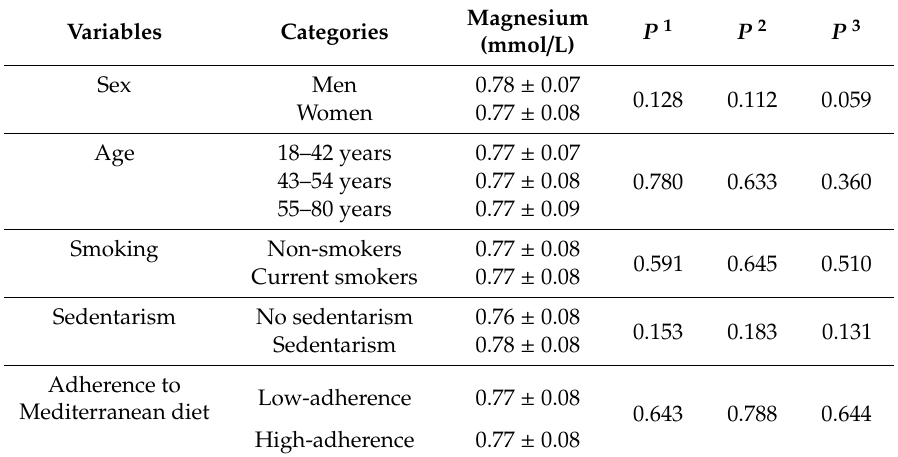
Table 2. Associations between plasma magnesium concentrations and socio-demographic and lifestyle variables in the whole